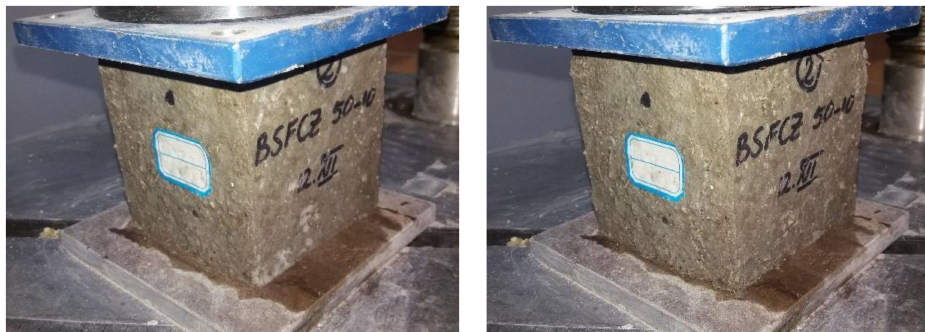
Figure 8. Composite control specimen, before and after compressive strength